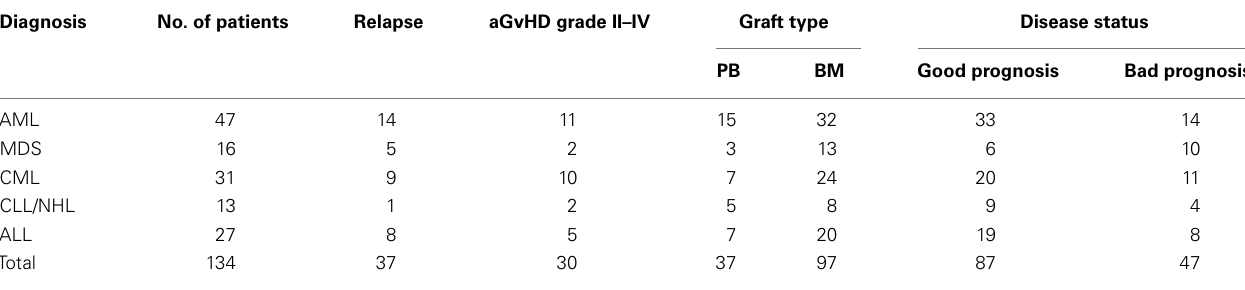
Table 1 |Altogether, 134 patients with 6 diagnoses were included in statistical analysis